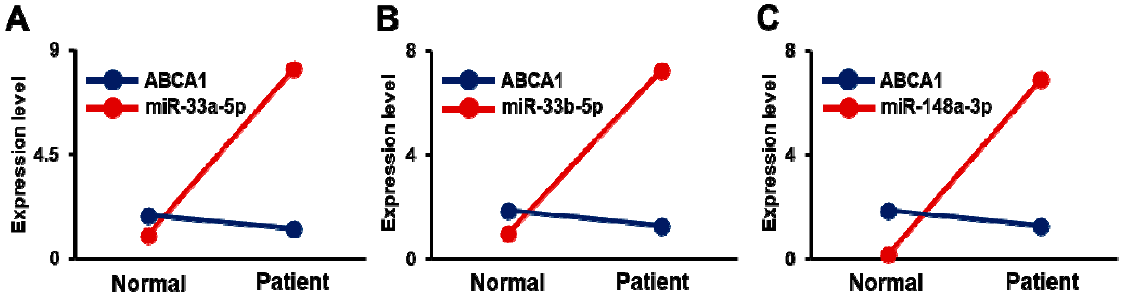
Figure 7. Correlation of ABCA1 and its target miRNAs in the plasma of carotid artery stenosis patients. Correlation between soluble ABCA1 and ( A ) miR-33a-5p, ( B ) miR-33b-5p, and ( C ) miR-148a-3p. Normal, plasma of non-carotid artery stenosis patient; Patient, plasma of carotid artery stenosis patient.